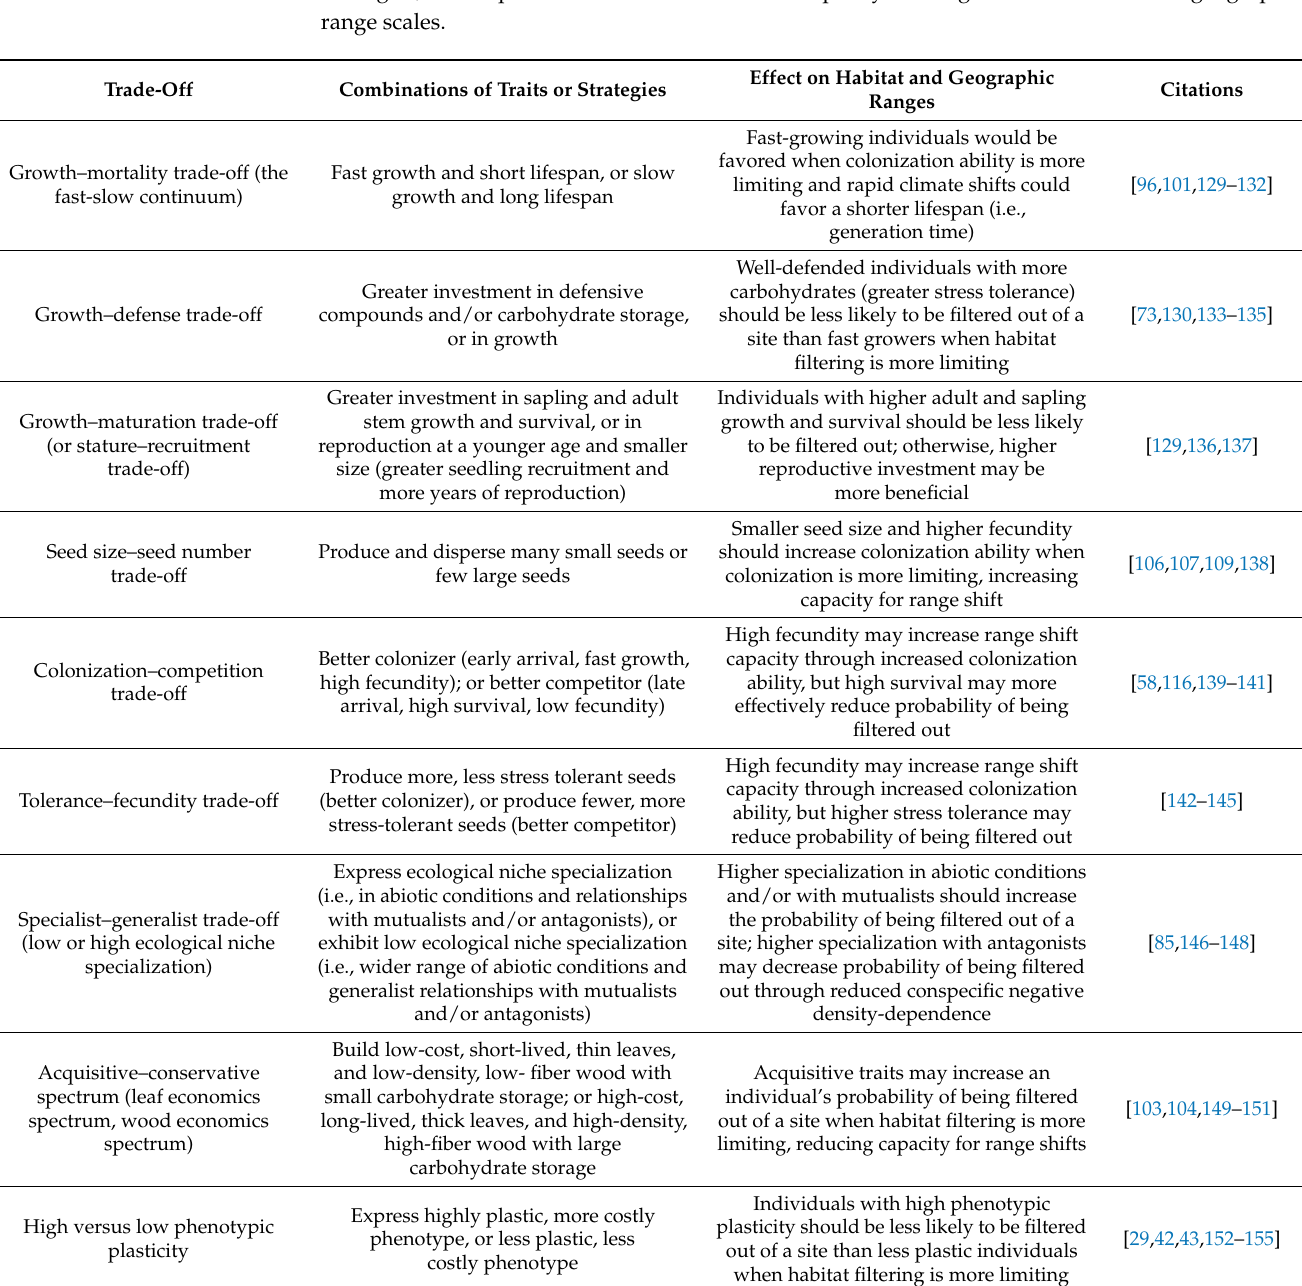
Table 1. Summary of the key whole-plant and trait-specific trade-offs in woody species’ ecological strategies, and implications of trade-offs for the capacity for range shifts at habitat and geographic range